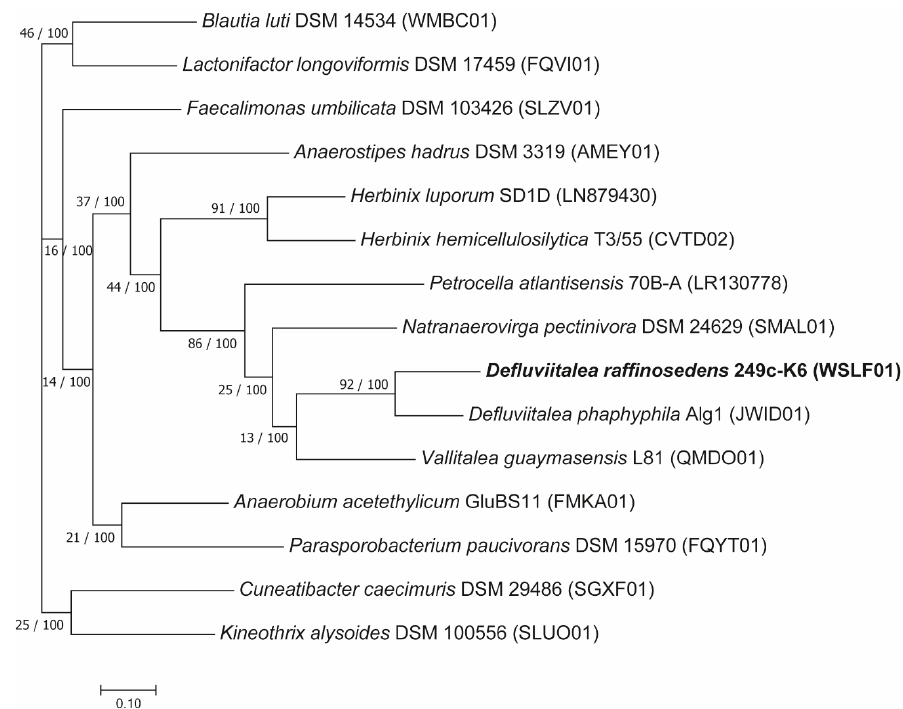
Figure 1. Phylogenetic position of D. raffinosedens isolate 249c-K6 in relation to the most closely related members of the class Clostridia . The tree was constructed applying the UBCG pipeline v. 3 [35] using standard settings based on 92 up-to-date bacterial core genes. In total, 86,940 nucleotide positions were used to build the concatenated alignment. For all branches, the number of examined genes (GSIs, gene support indices) supporting the given topology and bootstrap values are shown as follows: GSI / Bootstrap value. Bar, 0.01 substitutions per